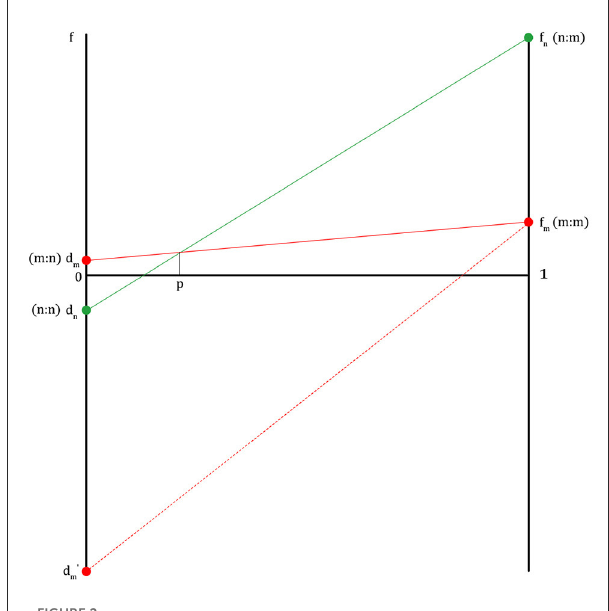
FIGURE2 The fitness lines of migraineurs and non-migraineurs on the condition that an agreement between migraineurs and non-migraineurs to help each other in danger is established (m, migraineur; n, non-migraineur; f, fitness; f m , fitness of m when m meets m; f n , fitness of n when n meets m; d m , fitness of m when m meets n; d n , fitness of n when n meets n; p, population proportion of migraineurs, at the right end of the graph, 1 is all migraineurs, at the left end, 0 is all non-migraineurs, d m ′ , fitness of m when m is betrayed by